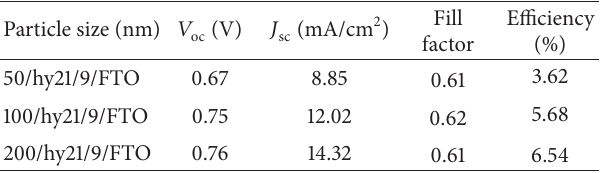
Table 5: Solar performance parameters of DSSCs with different particle sizes on the top in triple TiO 2